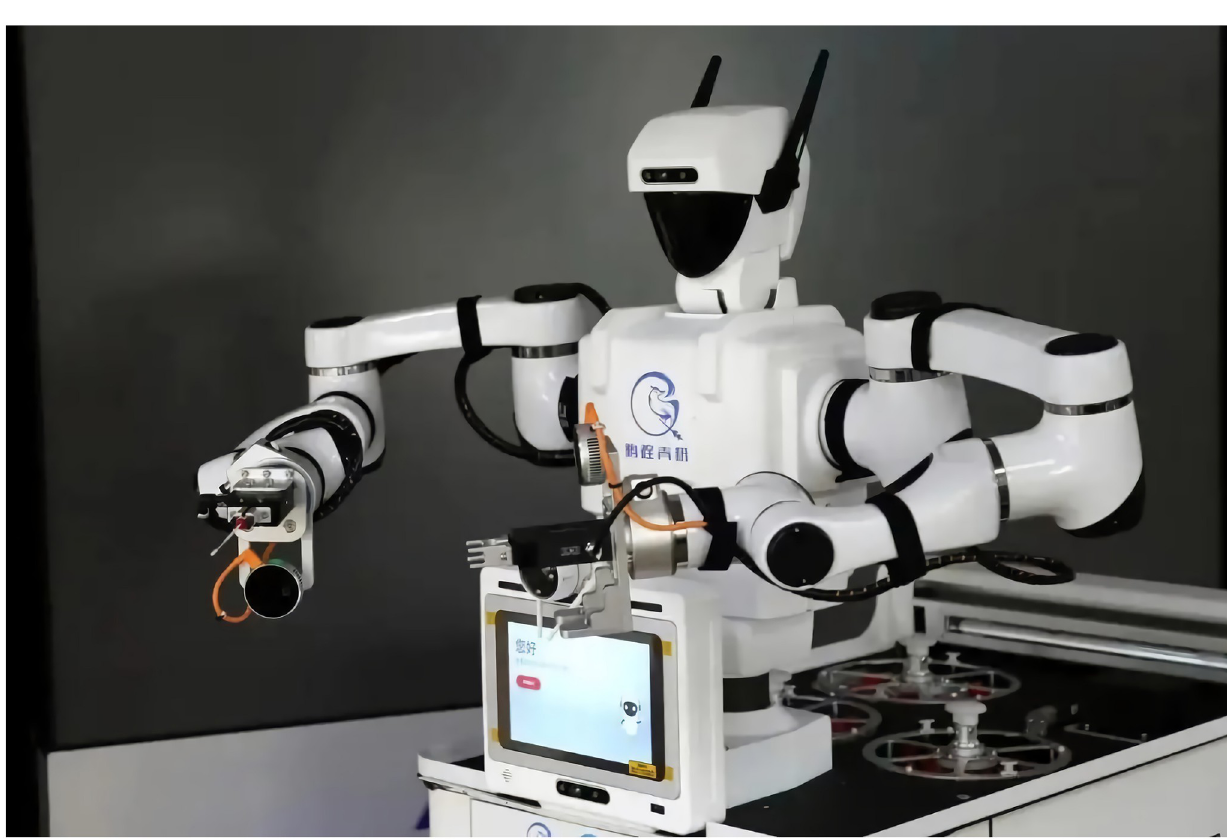
Fig 1. Picture of qinggeng